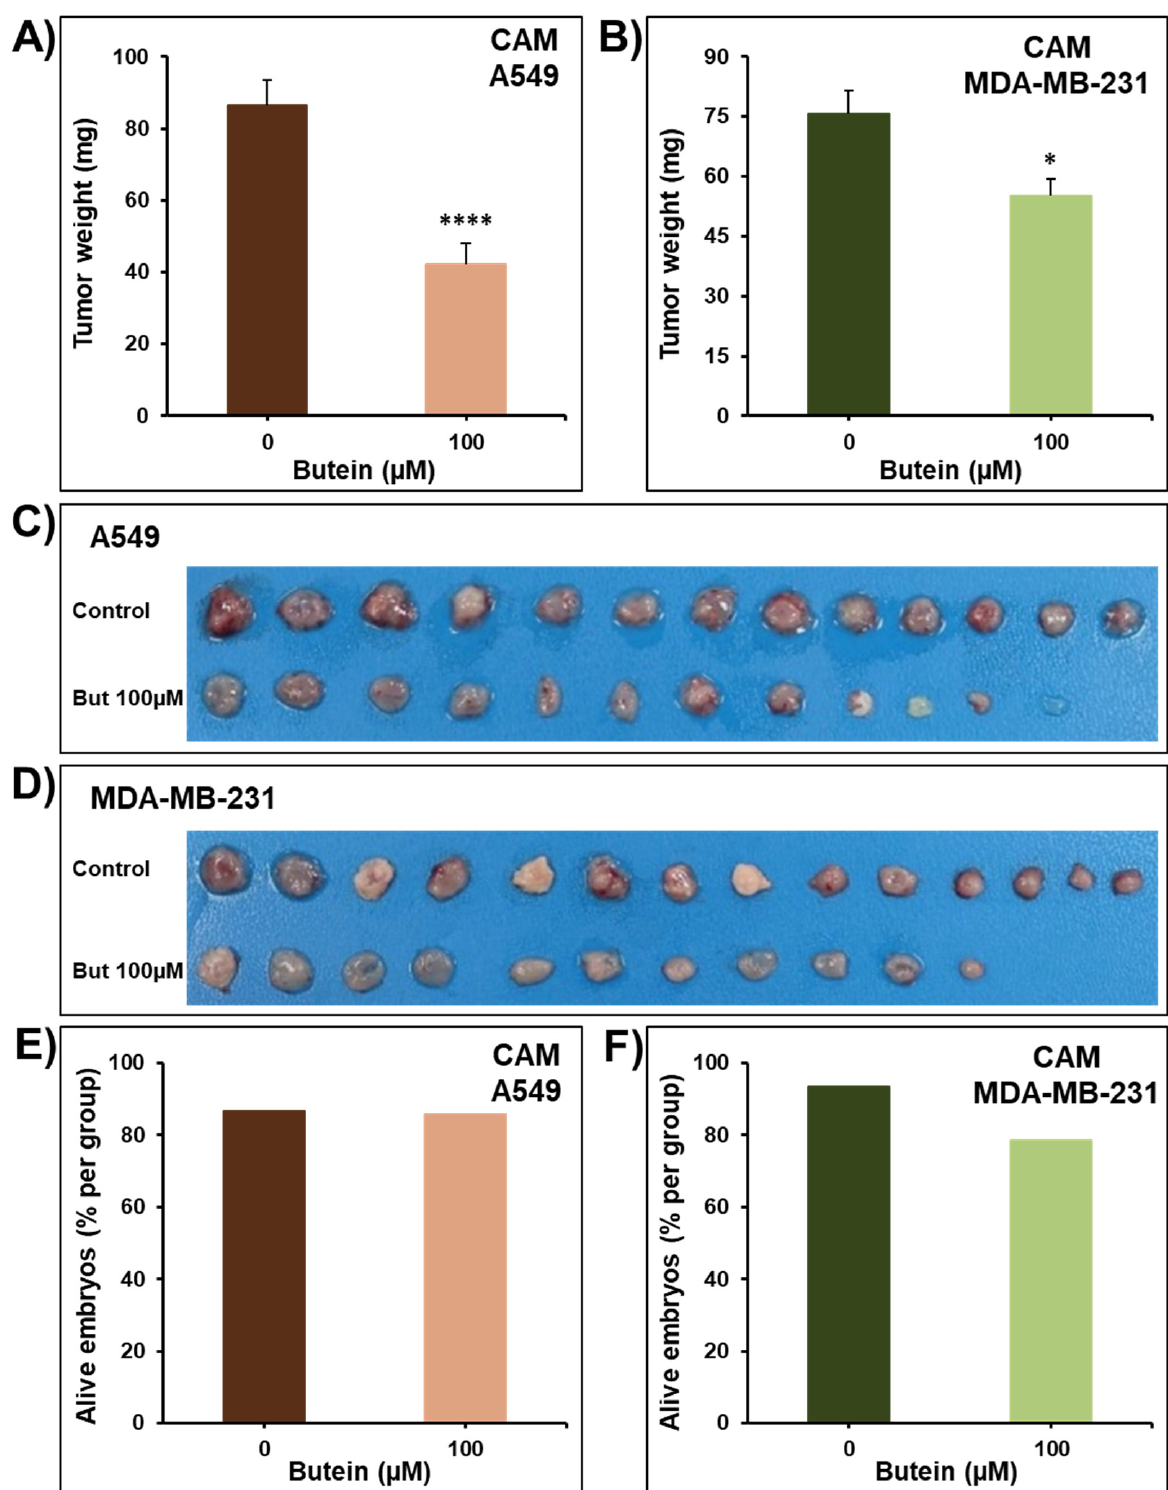
Figure 3. Impact of butein on tumor growth using the in vivo CAM tumor xenograft model. Volumes of 1 × 10 6 of A549 ( A , C ) and MDA-MB-231 ( B,D ) cells were grafted on the CAM of 9 days (E9) chick embryos. Tumors were treated with butein (100 µM) every 48 h for a total of 6 days. At E17, tumors were collected, weighed, and photographed ( C , D ). The viability of the chick embryos was assessed, and the percentage of alive embryos was determined ( E , F ). Columns are means; bars are S.E.M. * Significantly different at p < 0.05. **** Significantly different at p < 0.0001.